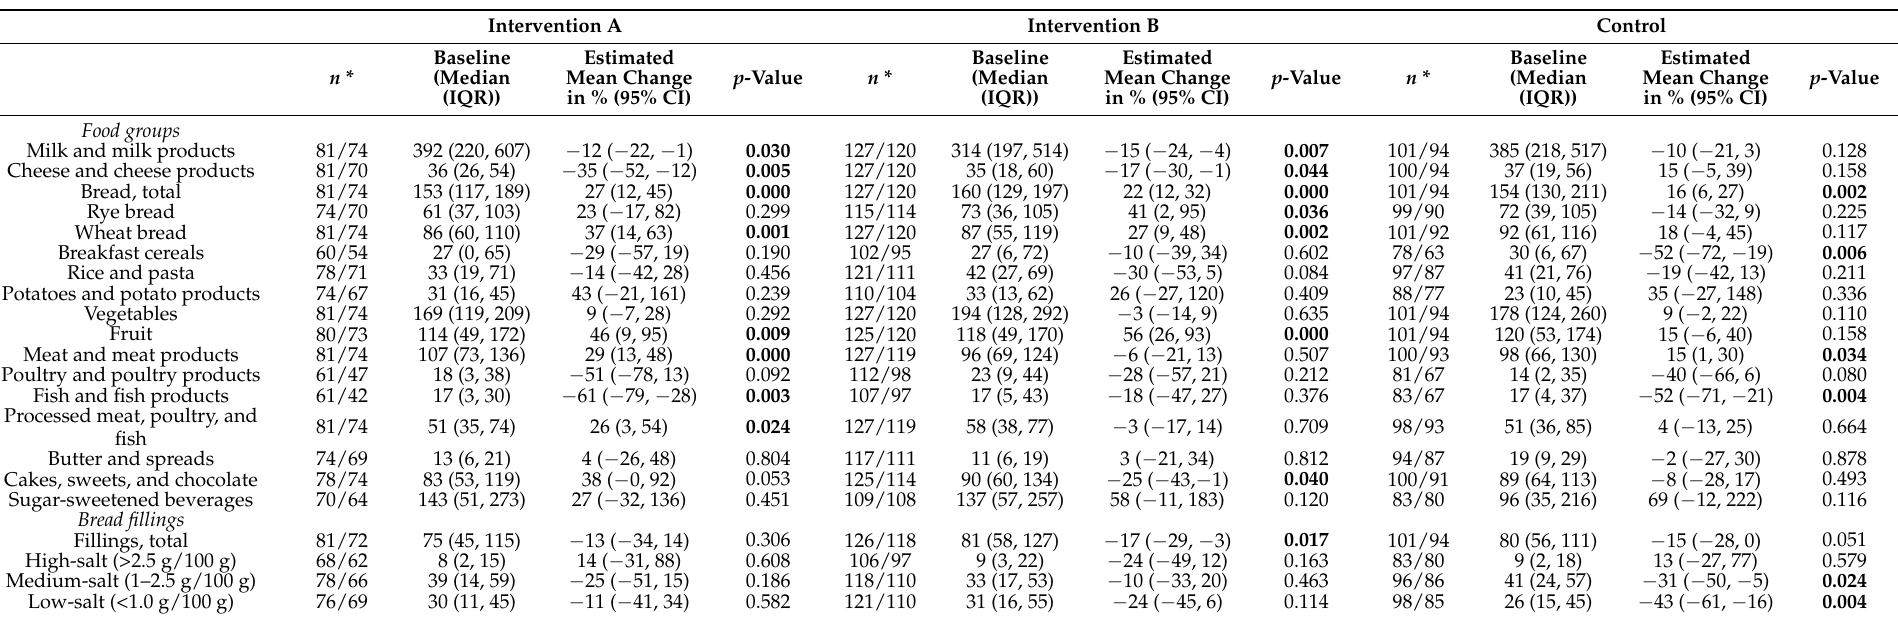
Table 3. Intake of food groups at baseline and estimated mean change from baseline to follow-up in the three groups (g/10